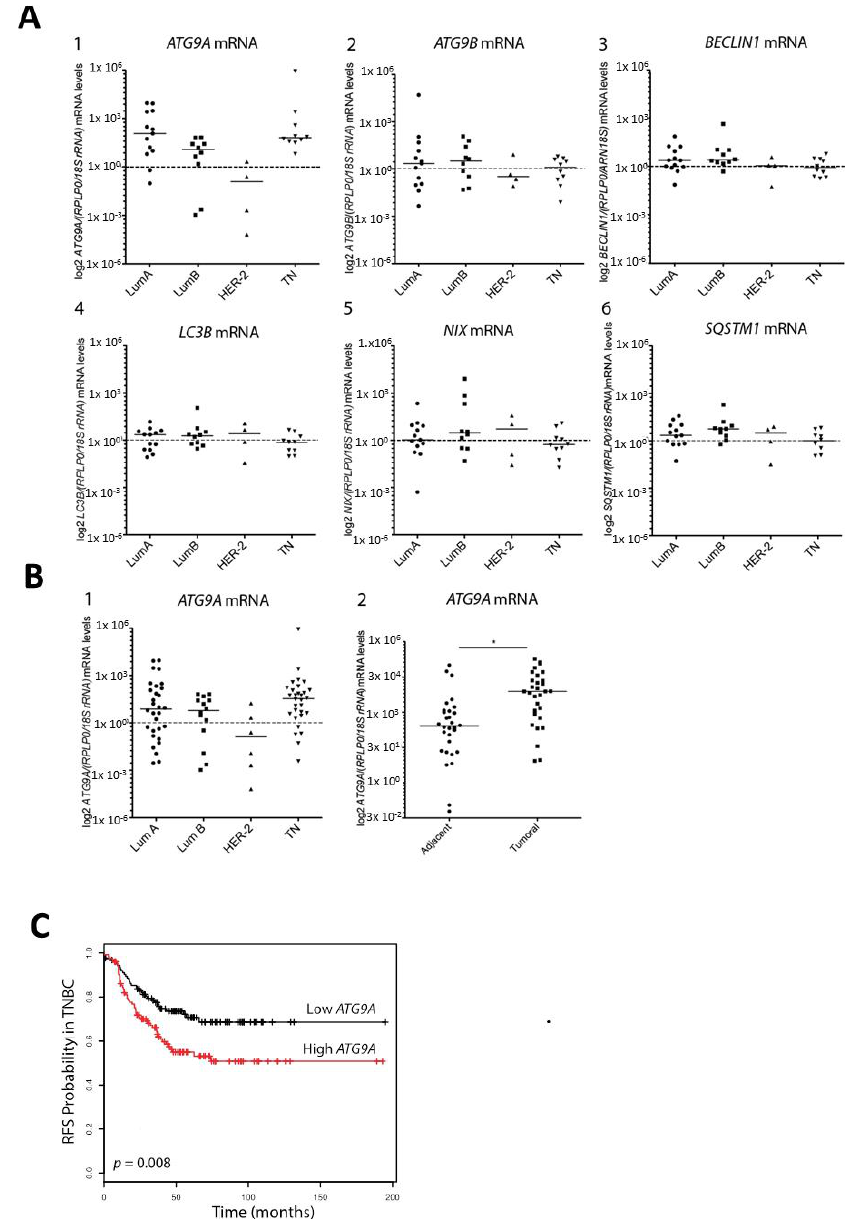
Figure 1. ATG9A mRNA overexpression in triple negative breast cancer. ( A ) Quantification of ATG9A , ATG9B , BECLIN1 , LC3B , NIX , and SQSTM1 mRNA levels using RT-qPCR, in Luminal A (LumA), Luminal B (LumB), HER2, and triple negative (TN) breast cancer biopsies compared to matched healthy adjacent tissues ( n = 37). Values were normalized to the ratio of two housekeeping genes, rRNA18S and RPLP0 . Data presented on scatter plots represent the log2 of ATG9A , ATG9B , BECLIN1 , LC3B , NIX , and SQSTM1 mRNA levels ratio in breast cancer biopsies over healthy adjacent tissues, for each patient. ( B ) The Left panel represents the ratio of ATG9A mRNA levels in LumA, LumB, HER2, and TN biopsies compared to matched healthy adjacent tissues (expanded cohort, n = 80). Data are expressed in log2 of relative ATG9A mRNA expression, for each patient, normalized with the ratio of two housekeeping genes: rRNA18S and RPLP0 . The Right panel represents the log2 of ATG9A mRNA levels in healthy adjacent tissues (left) and TN biopsies (right), normalized to the ratio of two housekeeping genes, rRNA18S and RPLP0 . Difference of expression was quantified using a paired t-test (* p = 0.0325). ( C ) Kaplan–Meier curves representing relapse-free survival (RFS) in TN patients expressing high ( n = 125) or low ( n = 124) ATG9A mRNA levels ( p = 0.008; source: